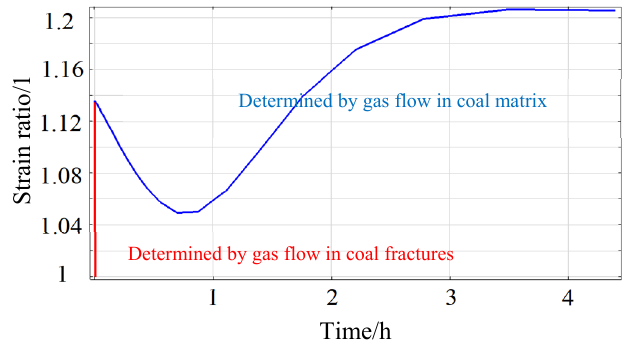
Figure 9. Deformation of coal fractures for Anderson coal.